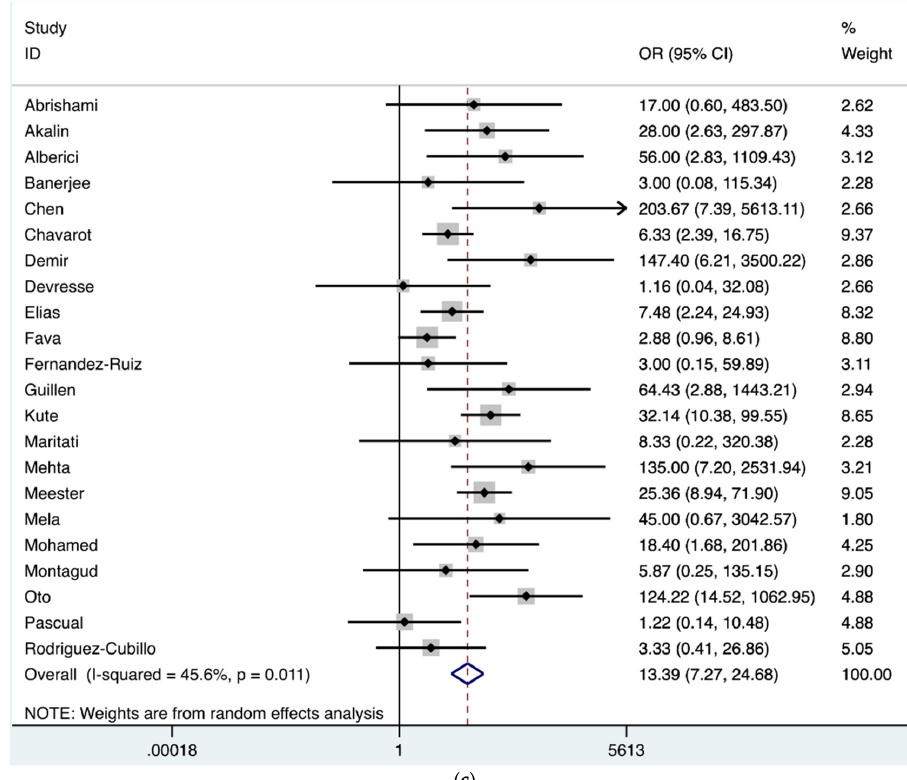
Figure 4. ( a ) Forest plot depicting COVID-19 associated mortality risk in kidney transplant recipients with ARDS in contrast to no ARDS. The diamond shows increased risk in patients with ARDS, OR = 19.59 (red dashed line). The edges of the blue diamond represent 95% confidence intervals (6.64–57.78). ARDS: Acute respiratory distress syndrome; ( b ) Forest plot depicting COVID-19 associated mortality risk in kidney transplant recipients on invasive ventilation in contrast to not on invasive ventilation. The diamond shows increased risk in patients receiving invasive ventilation, OR 3.80 represented by red dashed line with the edges of the blue diamond representing 95% confidence intervals (2.35–6.14); ( c ) Forest plot depicting COVID-19 associated mortality risk in kidney transplant recipients receiving critical care in contrast to hospital admission without critical care. The diamond shows increased risk in patients receiving critical care group, OR 13.39 represented by red dashed line with the edges of the blue diamond representing 95% confidence intervals (7.27–24.68). OR: Odds ratio.